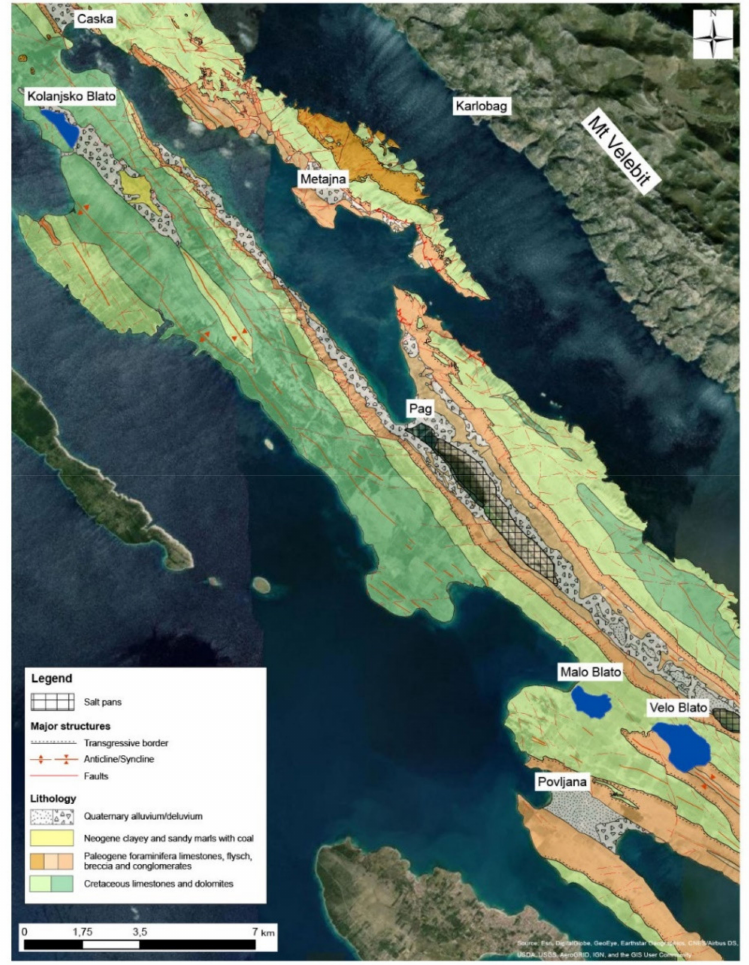
Figure 2. Geological map of the Island of Pag, with study locations Velo, Malo, and Kolanjsko Blato (modified after